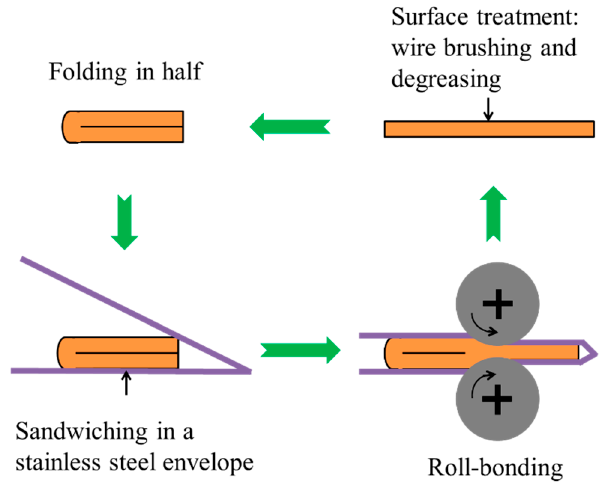
Figure 1. Schematic of the modified ARB process.